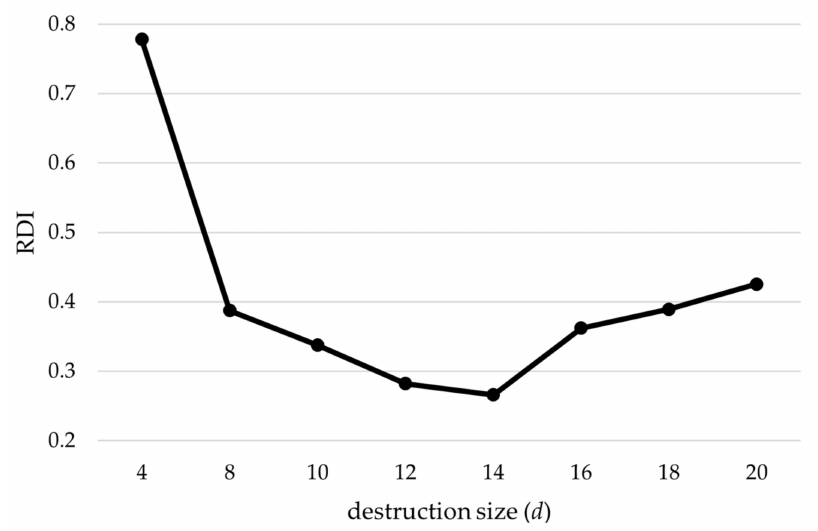
Figure 4. Calibration results of the proposed iterated greedy algorithm.